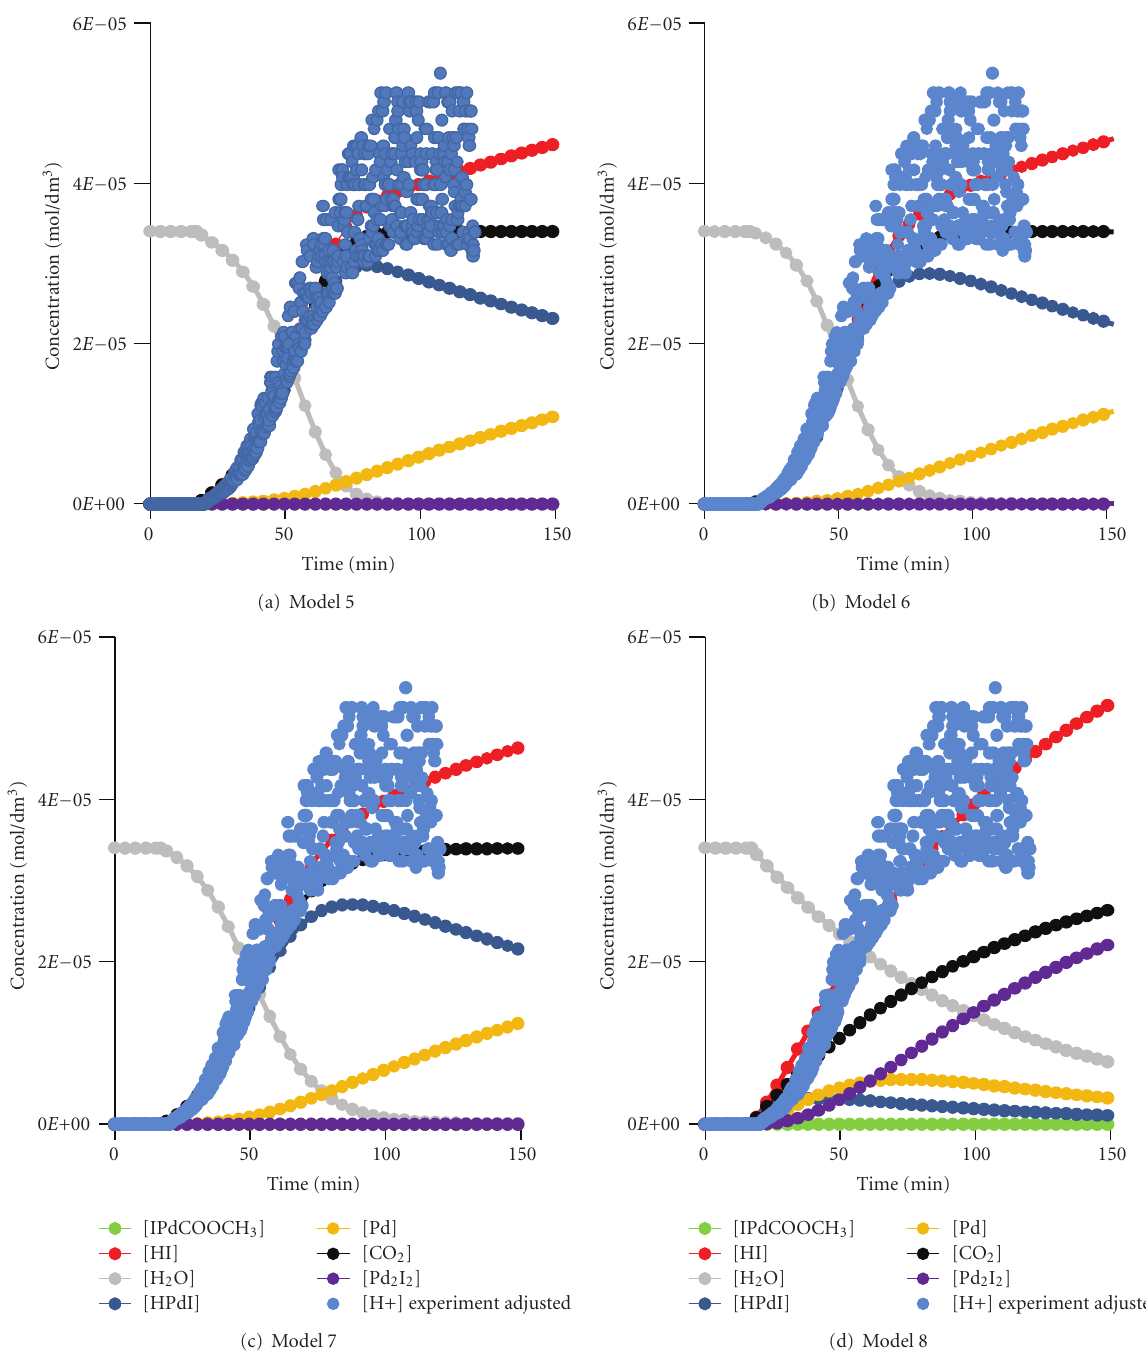
Figure 10: Fitted data using models 5–8 against experimental data presented in Figure